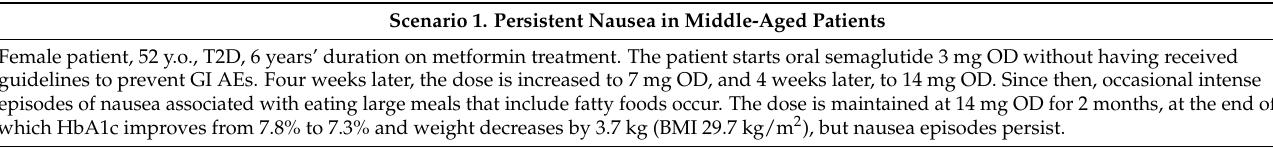
Table 4. Clinical scenarios of interest to exemplify GI AE management during GLP-1 RA